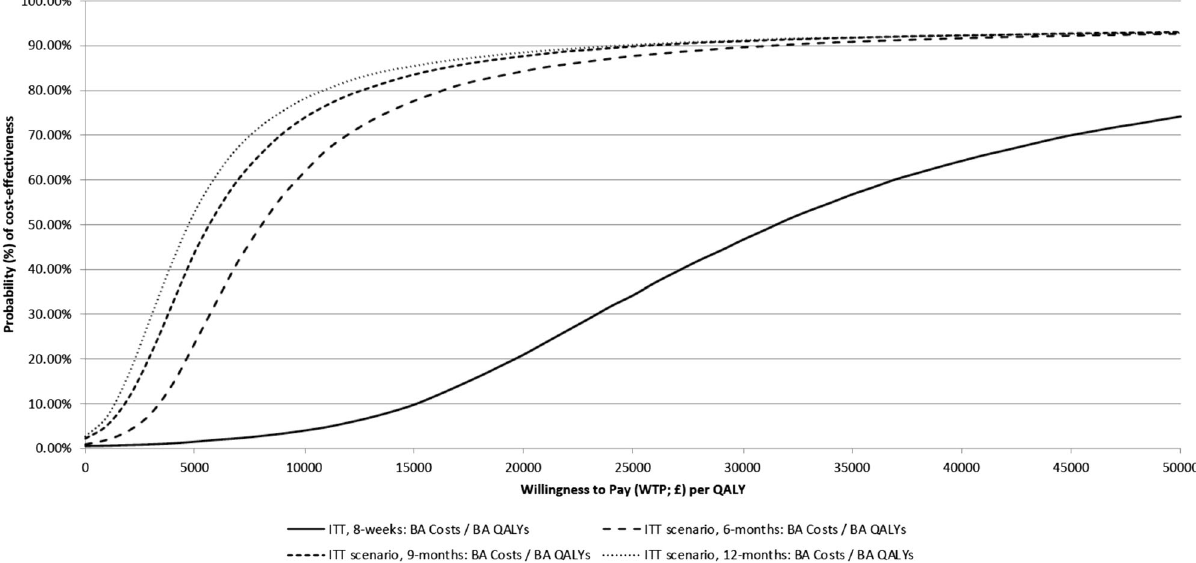
Fig. 4 CEAC representing probability of cost-effectiveness of iCBT relative to waiting-list control over 8 weeks, and predicted over 6, 9, and 12 months. ITT Intention-to-treat, BA Baseline-Adjusted; QALY Quality-Adjusted Life